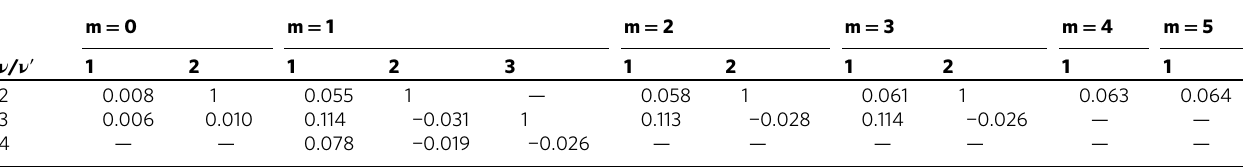
Table 2 Orthogonality of the disk PWFs